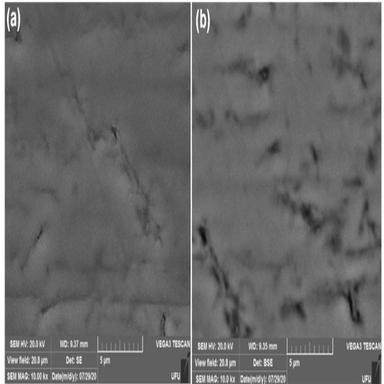
Surface SEM images of the Ti6Al4V alloy coated with Nb2O5 thin film, (a) SE image of the Ti6Al4V alloy, and (b) BSE image. Magnification of 10.0 kx.